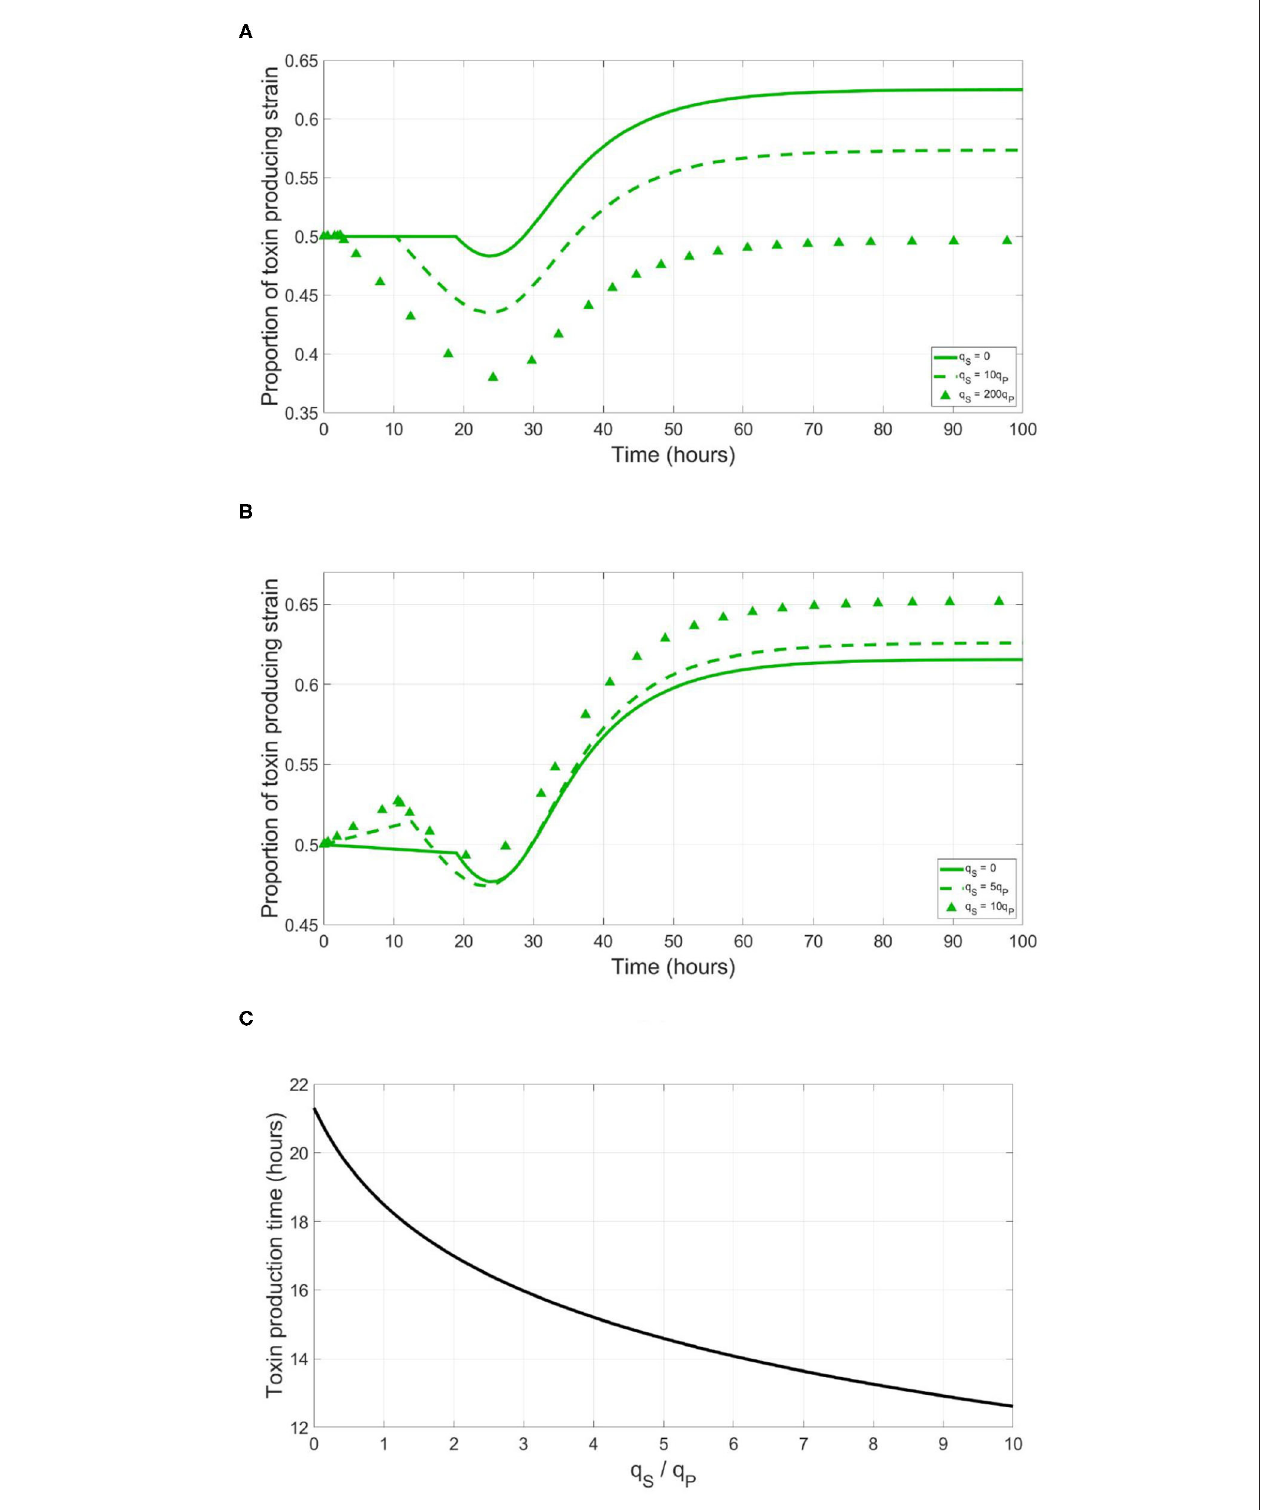
FIGURE 3 | Producing dishonest signals by a sensitive strain could be an advantageous strategy when competing with a focal QS strain. However, this will depend on the metabolic cost of the signaling system. (A) The time evolution of the focal QS toxin producing strain in a competition with a sensitive strain, expressed as a